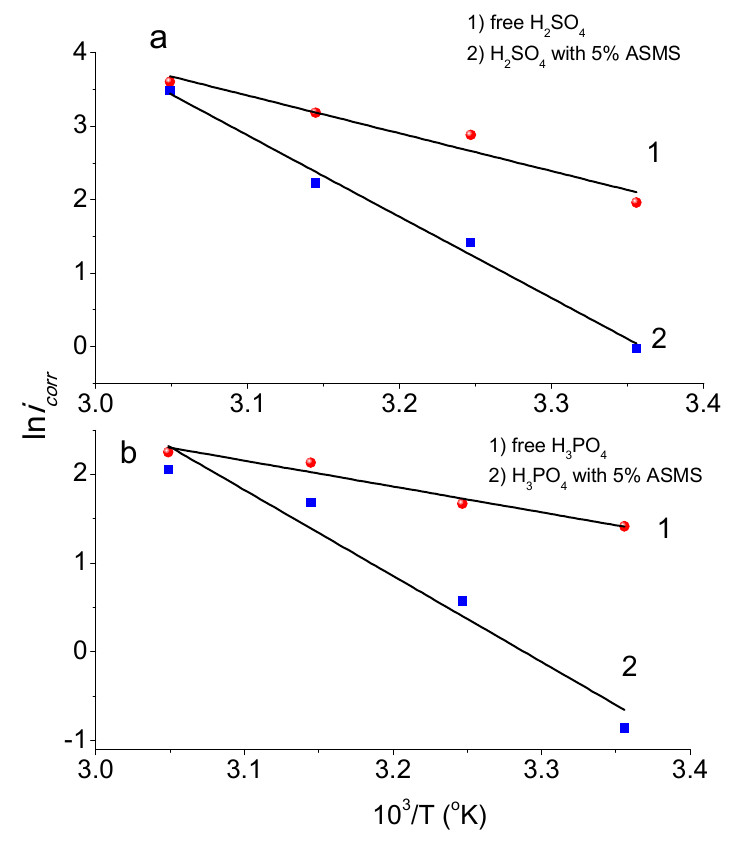
Figure 8. Arrhenius relationship for H 3 PO 4 ( a ) and H 2 SO 4 ( b ) with and without 5% ASMS.